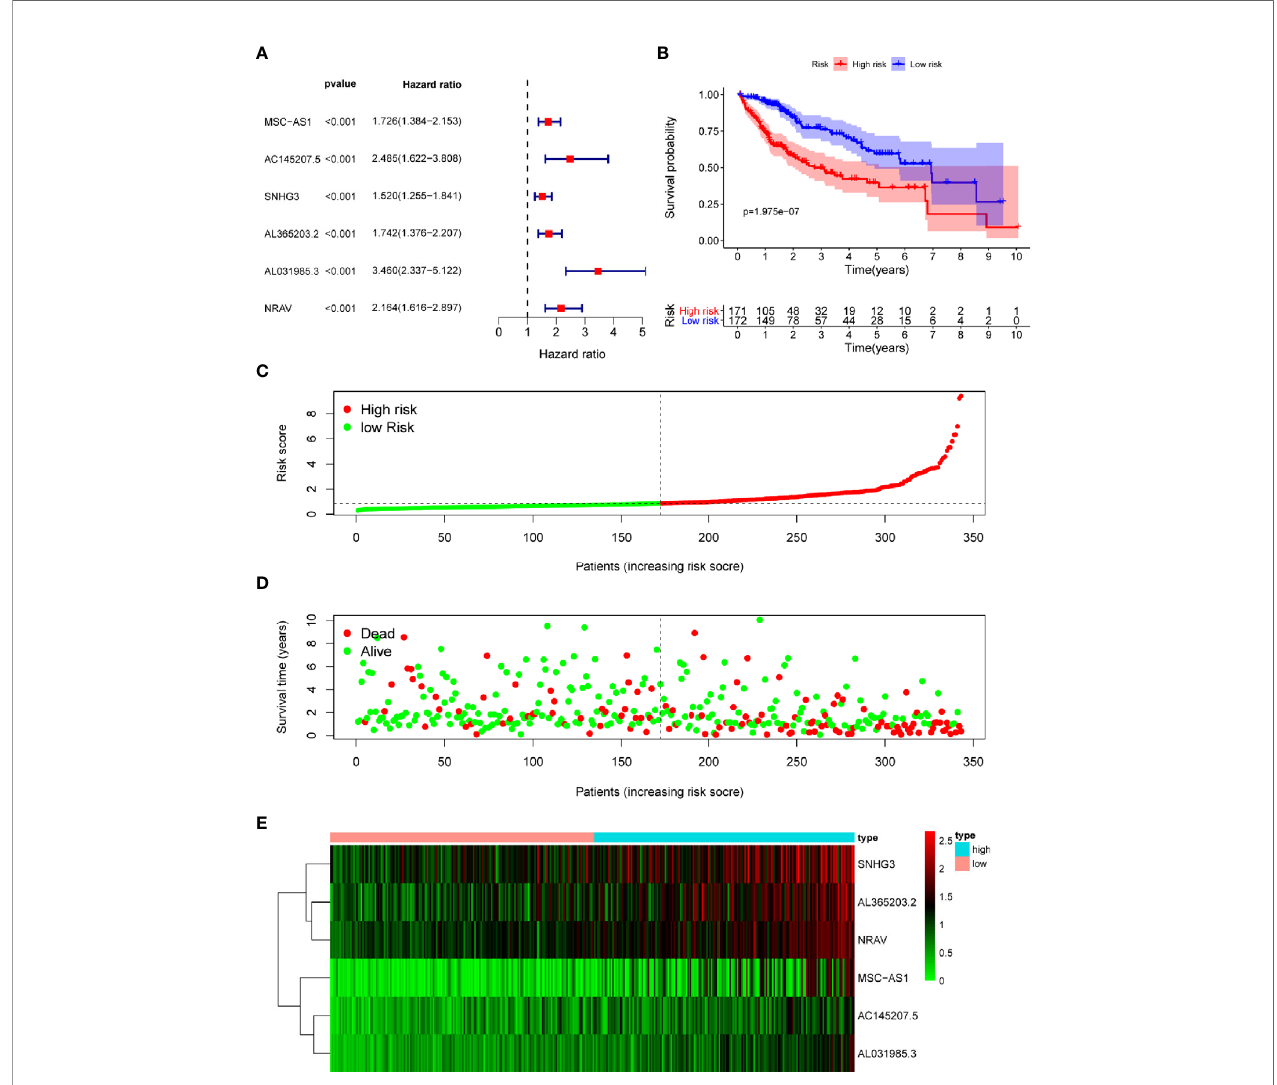
FIGURE 2 | Construction and assessment of immune-related lncRNA prognostic signature for HCC. (A) The HR and p-value from the univariable Cox regression of selected immune-related lncRNAs (MSC-AS1, AC145207.5, SNHG3, AL365203.2, AL031985.3, NRAV) according to the criterion of p < 0.0001. (B) Kaplan-Meier survival curves showed that the overall survival of the high-risk groups was signi fi cantly lower than that of the low-risk groups. (C) HCC samples were divided into high-risk groups and low-risk groups according to the median value of risk score. (D) A higher mortality was observed in high-risk groups than in low-risk groups. (E) The heatmap showed that with the increase of risk score, the expression levels of lncRNAs were